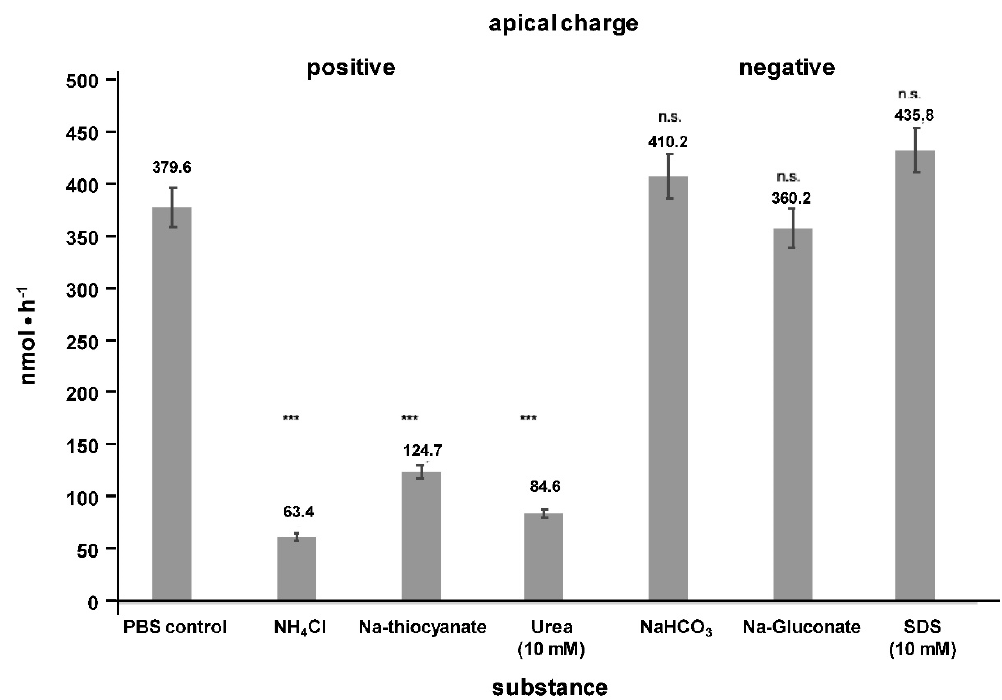
Figure6. Ionicdrivingforcesforapicaltranslocationofphosphatidylcholine(PC)inpolarizedMz-ChA-1 cells. Apical transport of basally applied 10 mM PC: 10 mM taurocholate was examined in polarized (21 days cultured) Mz-ChA-1 cells apically equilibrated for 1 h with indicated salts and substrates (130 mM) generating apical positive or negative charge. Means ± SD of n = 6. Significances were calculated in relation to the phosphate-bu ff ered saline (PBS) control; n.s. = not significant, *** p <